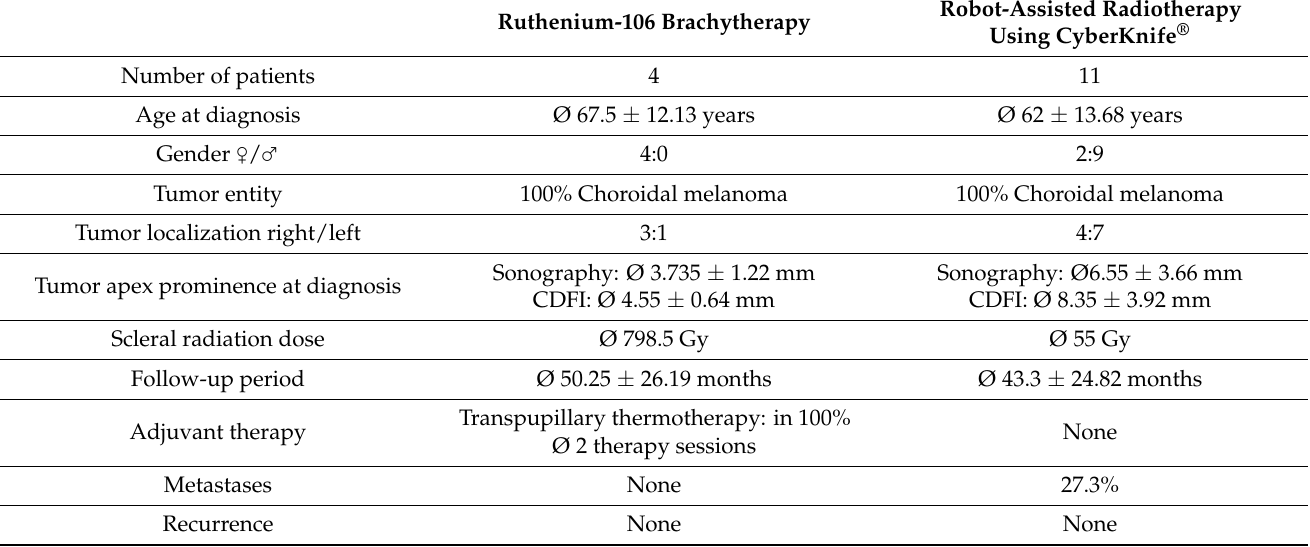
Table 2. Demographics and clinical data of the enrolled patients treated by either ruthenium-106 brachytherapy or robot-assisted radiotherapy using CyberKnife ® . Robot-Assisted Radiotherapy Ruthenium-106 Brachytherapy Using CyberKnife